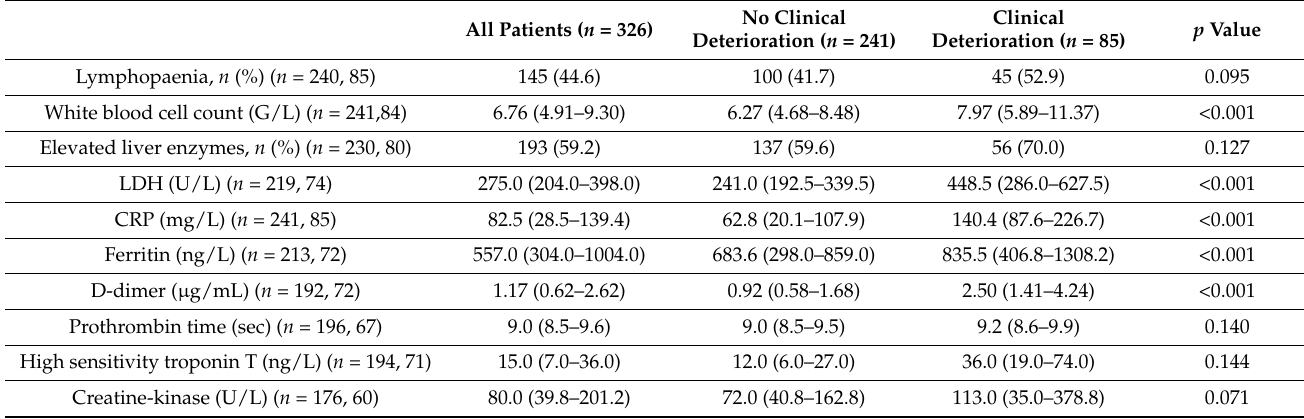
Table 2. Laboratory characteristics of the patients.